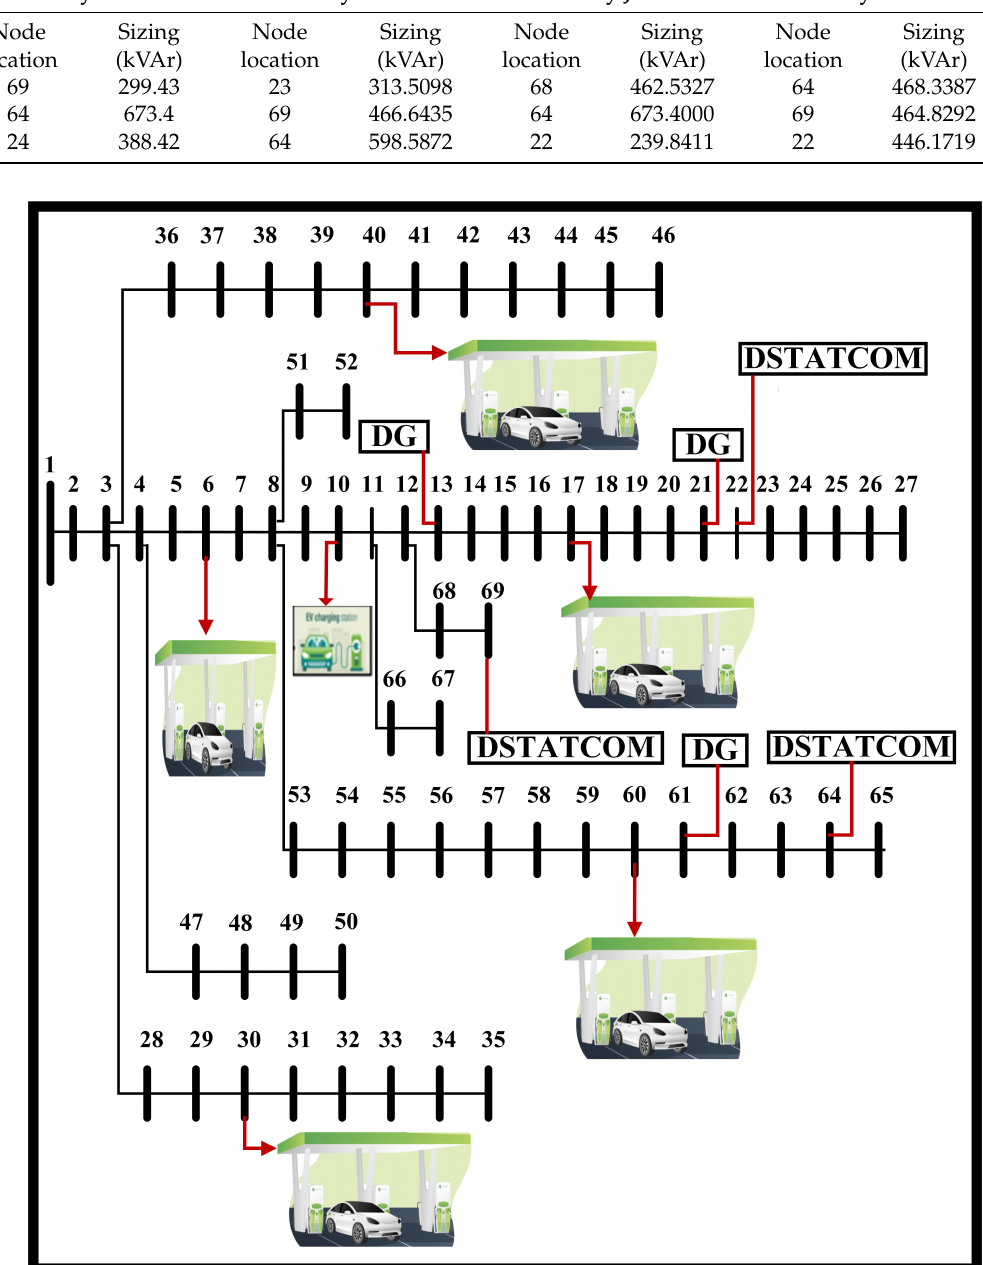
Figure 14. The single-line diagram of the 69-bus radial distribution system of scenario